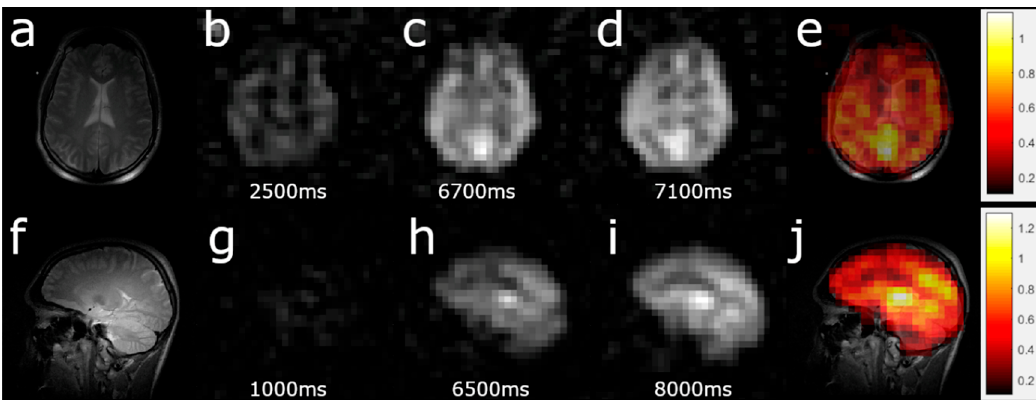
Figure 3. Example of perfusion map acquisition. ( a , f ) High-resolution, T 2 -weighted 1 H scans for brain localization. ( b – d ) Three dynamic HP 129 Xe TOF images acquired 2.5 s, 6.8 s, and 7.1 s after the application of a depolarization radiofrequency pulse in the axial projection. The image artifact in the top left corner in b is from excess gaseous 129 Xe at the end of the inhalation tube connected to the TedLar bag. The gradual signal-to-noise ratio increase can be observed with increasing wash-in time. The slope map was created by a pixel-by-pixel linear fit of the 129 Xe brain images. ( e ) The perfusion map (measured in mL of blood per mL of tissue per min) created by the pixel-by-pixel recalculation of the TOF slope was used to calculate the sum of the perfusion rates of gray and white matter superimposed on top of a high-resolution proton brain image. The calculated values of perfusion agreed with previously observed values [41,46]. ( g – i ) Three dynamic TOF images acquired after 1s, 6.5 s, and 8 s TOF in the sagittal view. ( j ) Perfusion map in the sagittal view. Similar to e , the intensity values were the net sum of the white and gray matter perfusion rates.